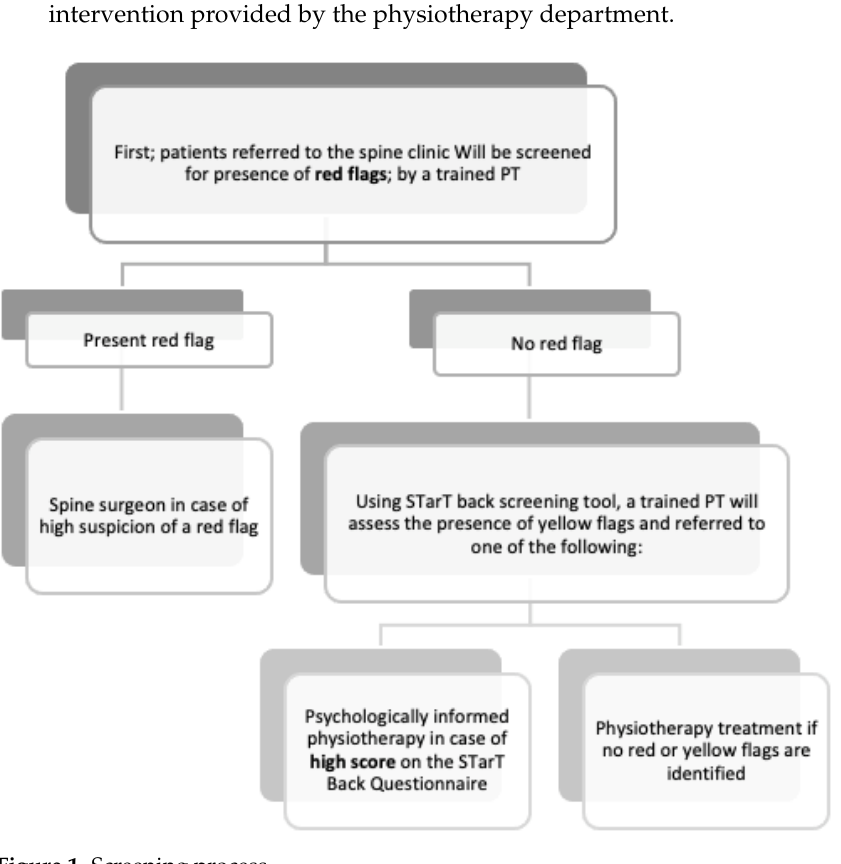
Figure 1. Screening process.